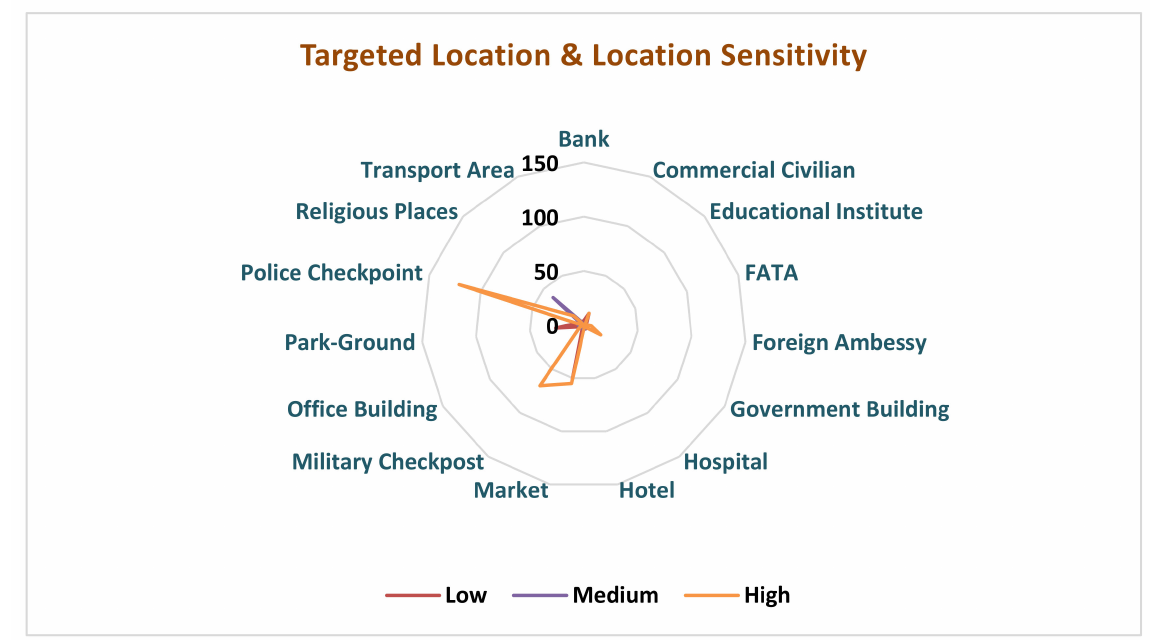
Figure 5. Visual analysis of the distribution of the targeted location by suicide attackers and sensitivity of that particular